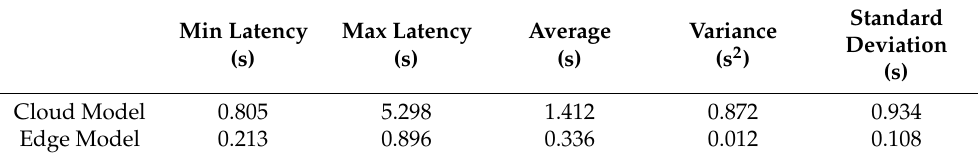
Table 2. Round trip delay (RTD) test of 300 samples of the edge and cloud